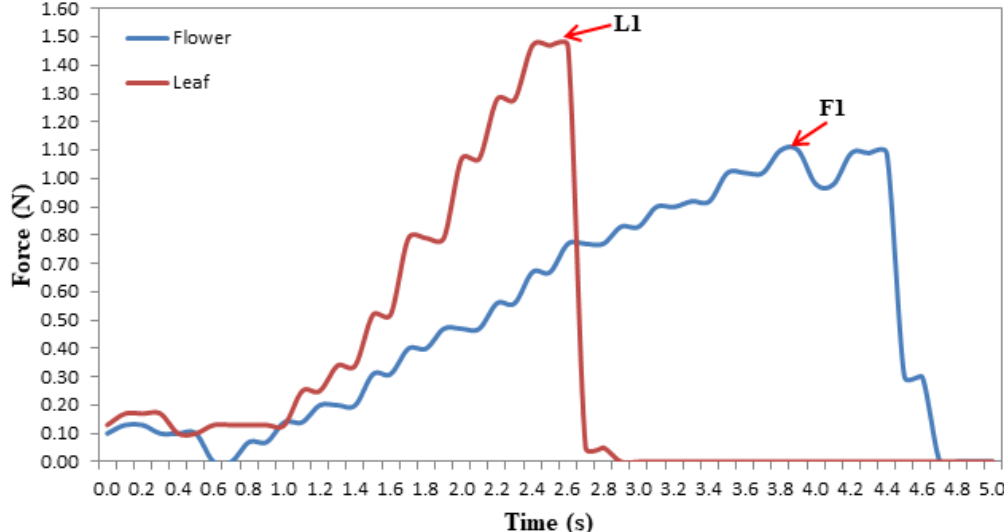
Figure 8. The detachment experiments results of the flowers and leaves.